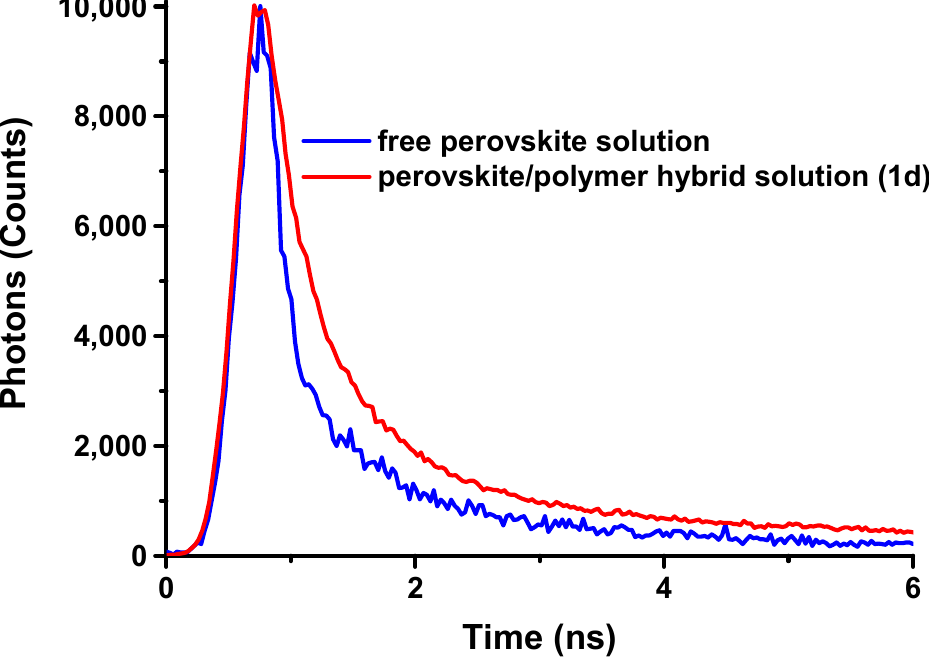
Figure 5. Lifetime decays of perovskite solution of C = 50.08 mM dispersed in toluene, without the presence of the random copolymer, (blue line) and Sample 1d (red line).